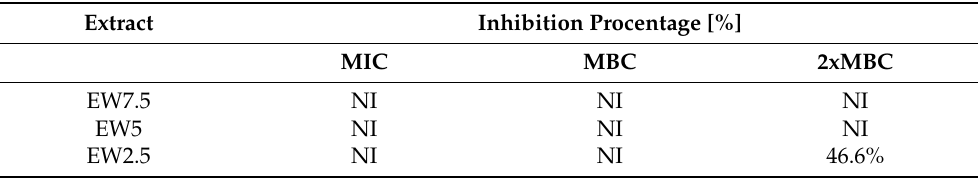
Table 7. Antibiofilm activity of different Allium scrorodoprasum flower extracts on formed biofilm of Staphylococcus lugdunensis